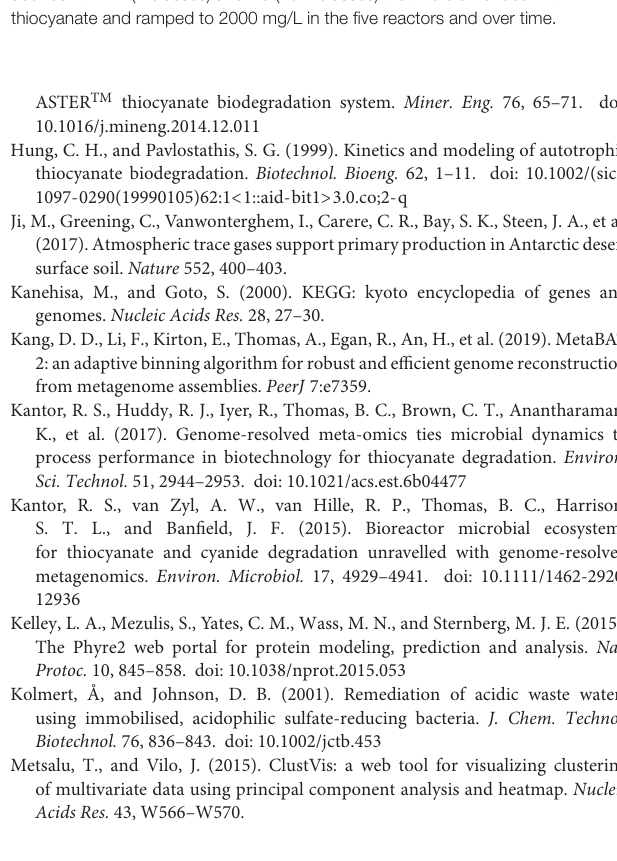
Supplementary Figure 3 | Principal coordinate analysis of community composition at the first two time points in all reactors. The rectangular box shows